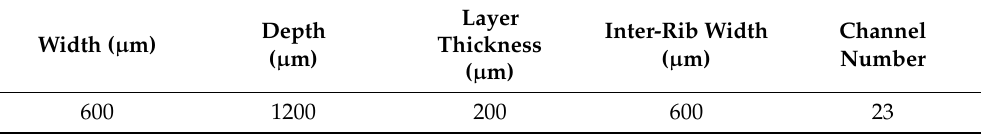
Figure 4. Schematic diagram of sintered porous microchannel and copper plate.